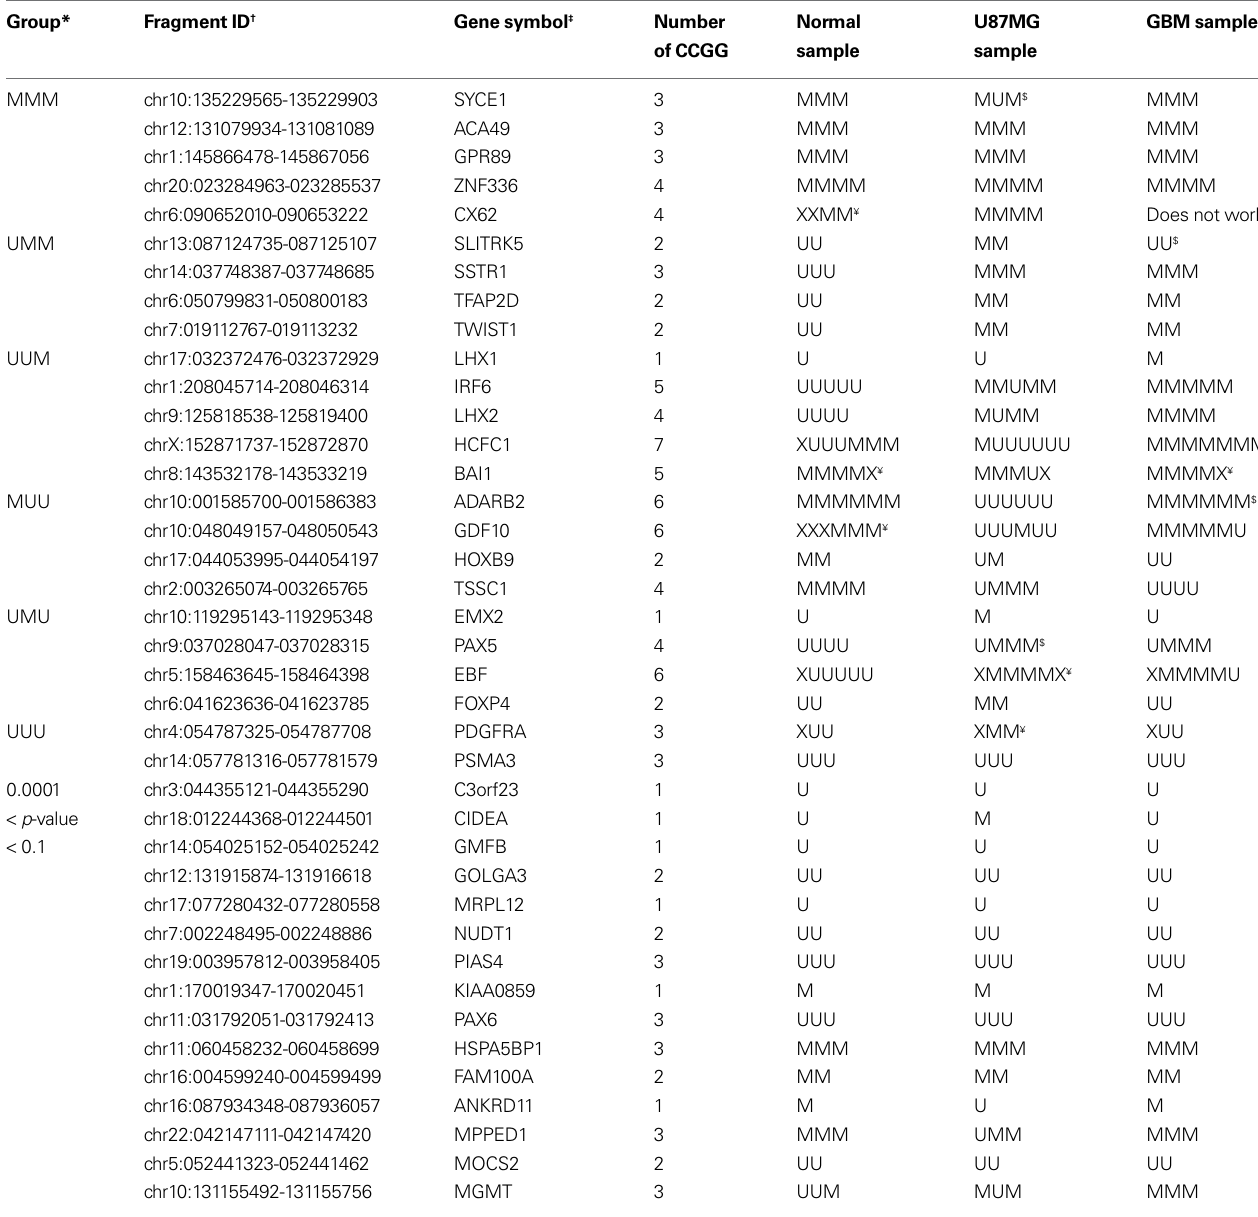
Table 2 | Bisulfi te sequencing validation of selected